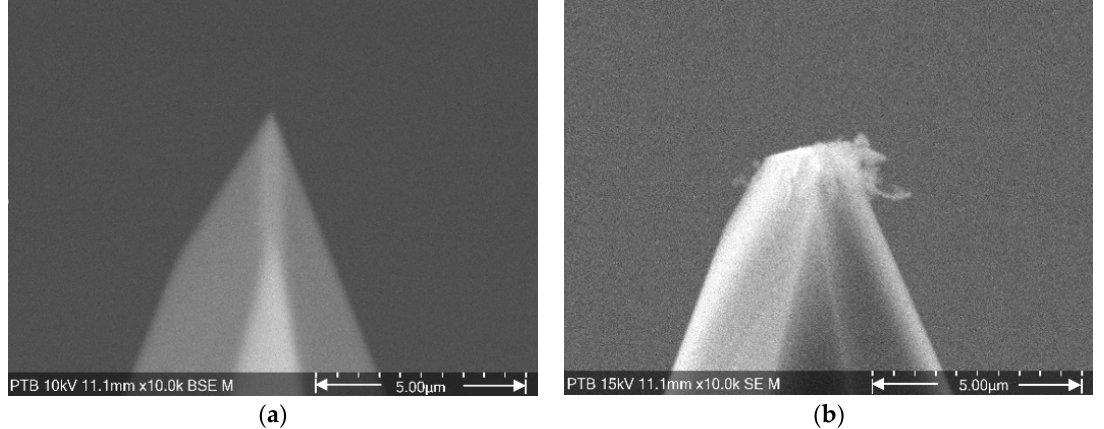
Figure 2. The microprobe tip geometry changes during roughness measurements. ( a ) New tip with a radius of approximately 0.1 µm; ( b ) the tip end becomes flat and wide after 300 m of roughness measurement.